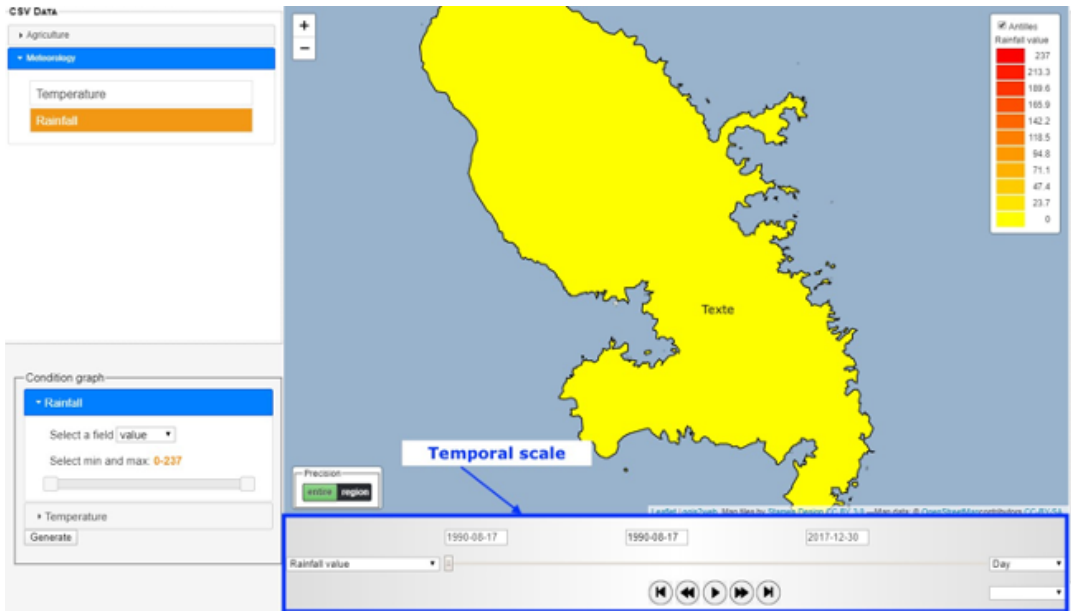
Figure 6. DKP temporal parameters and player